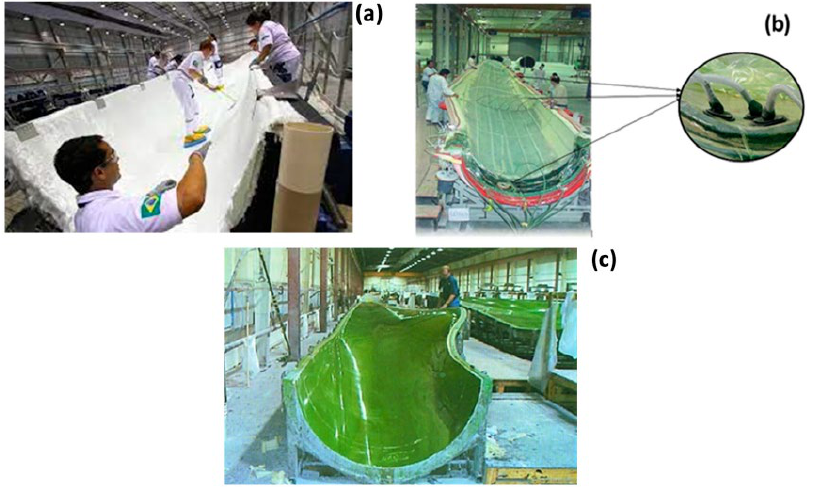
Figure 3. Manufacturing processes of a wind turbine blade ( a ) hand lay-up, ( b ) vacuum infusion or prepregging, ( c ) vacuum-assisted resin transfer molding (VARTM) [19].